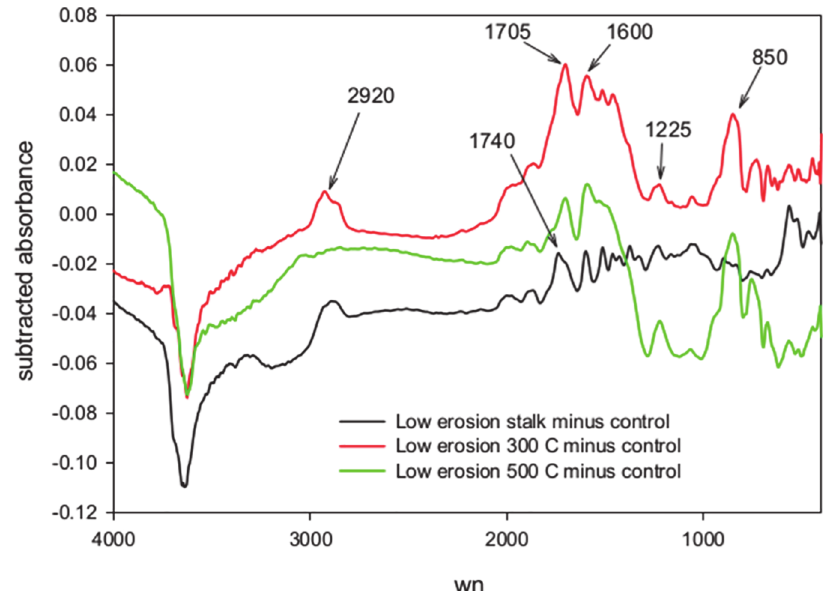
Fig 5. Spectral subtraction of the time zero and 48 week incubated soil-char mixes for the eroded and non-eroded soils. Soil amendments were corn stalks, 300 °C char and 500 °C char. wn = wavenumbers in cm -1